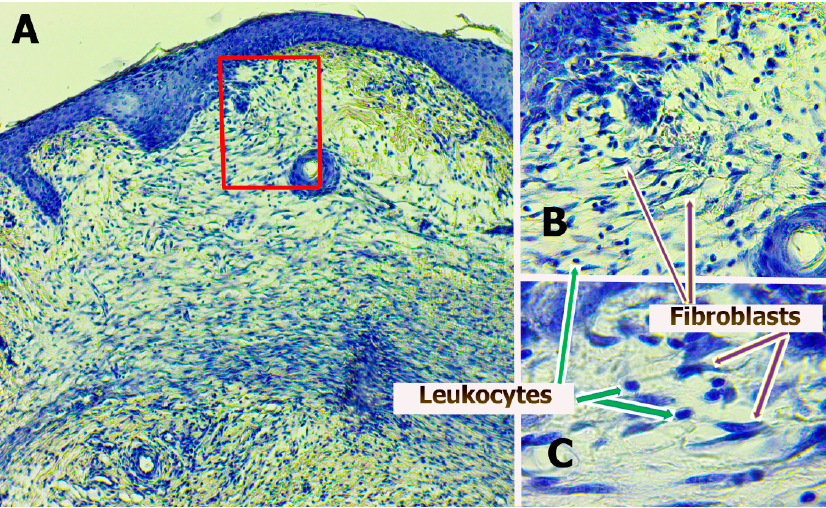
Figure 1. Edge of wounds, group SPN + SC on Day 7. Leukocytes (round cells) and fibroblasts (elongated cells with elongated nuclei, they produce the intercellular substance) are visualized. Hematoxylin. ( A ). Magnification ×100. ( B ). Magnification ×400. ( C ). Magnification ×1000.